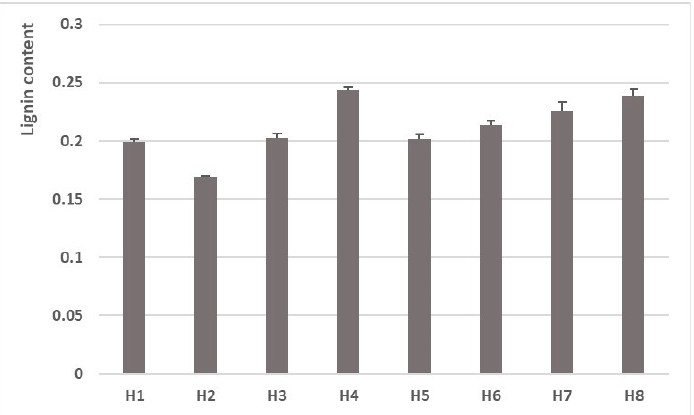
Figure 9. Lignin content in flax at different developmental stages. The periods represented by H1–H8 are shown in Figure 5. Lignin content data were obtained from Yuan et al. [2]. Table 2. Correlation analysis between LuF5H expression and lignin content.